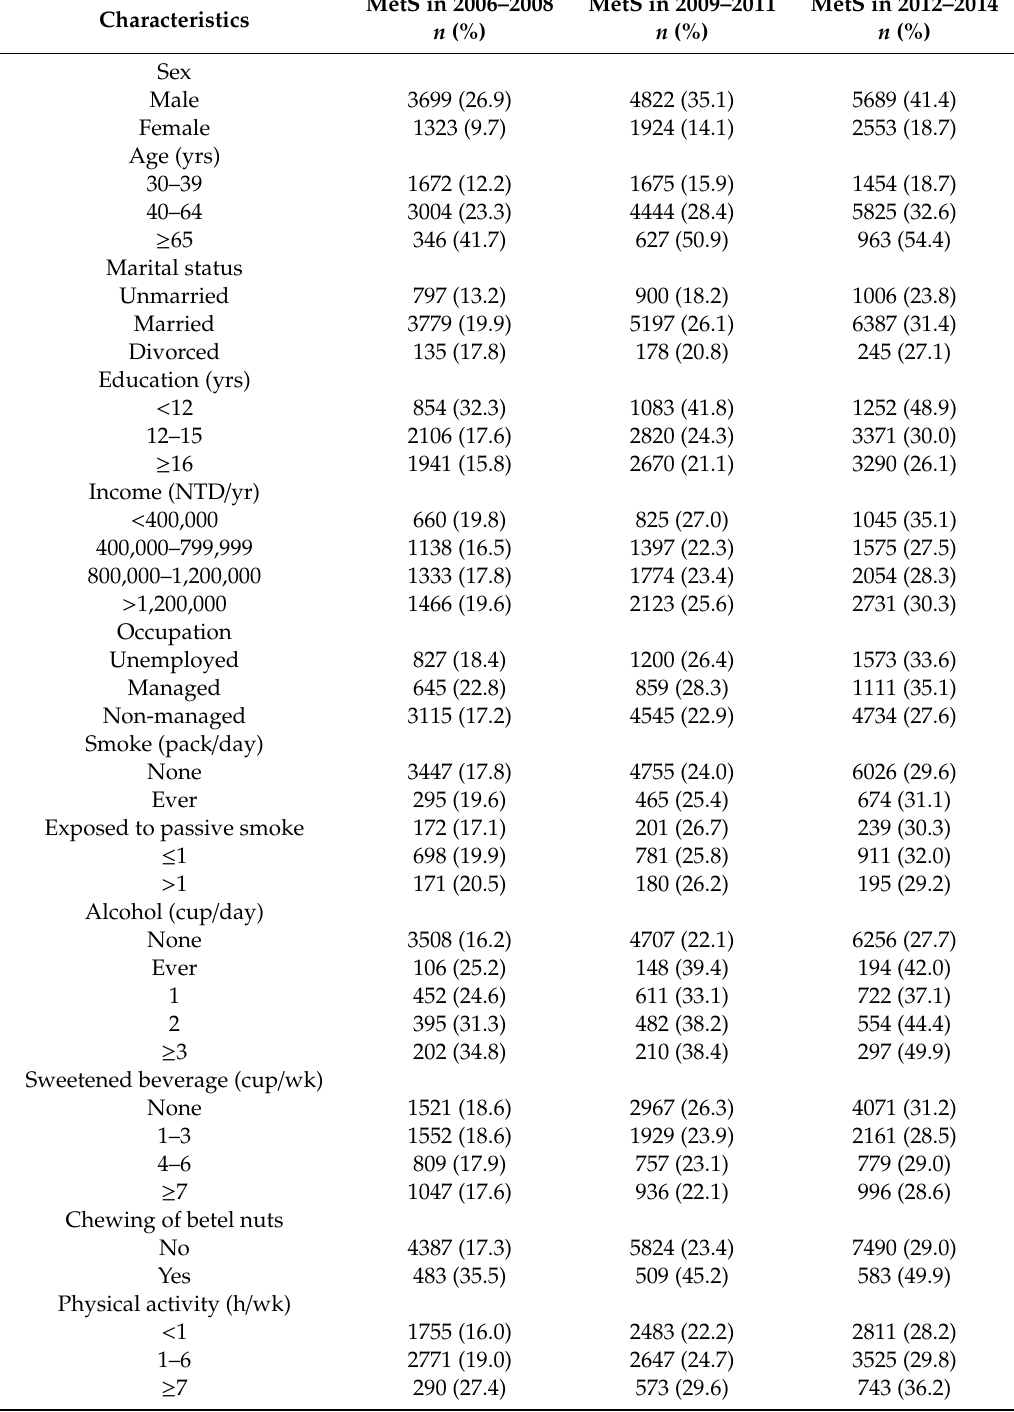
Table 1. Metabolic syndrome (MetS)-related explanatory variables across the three study